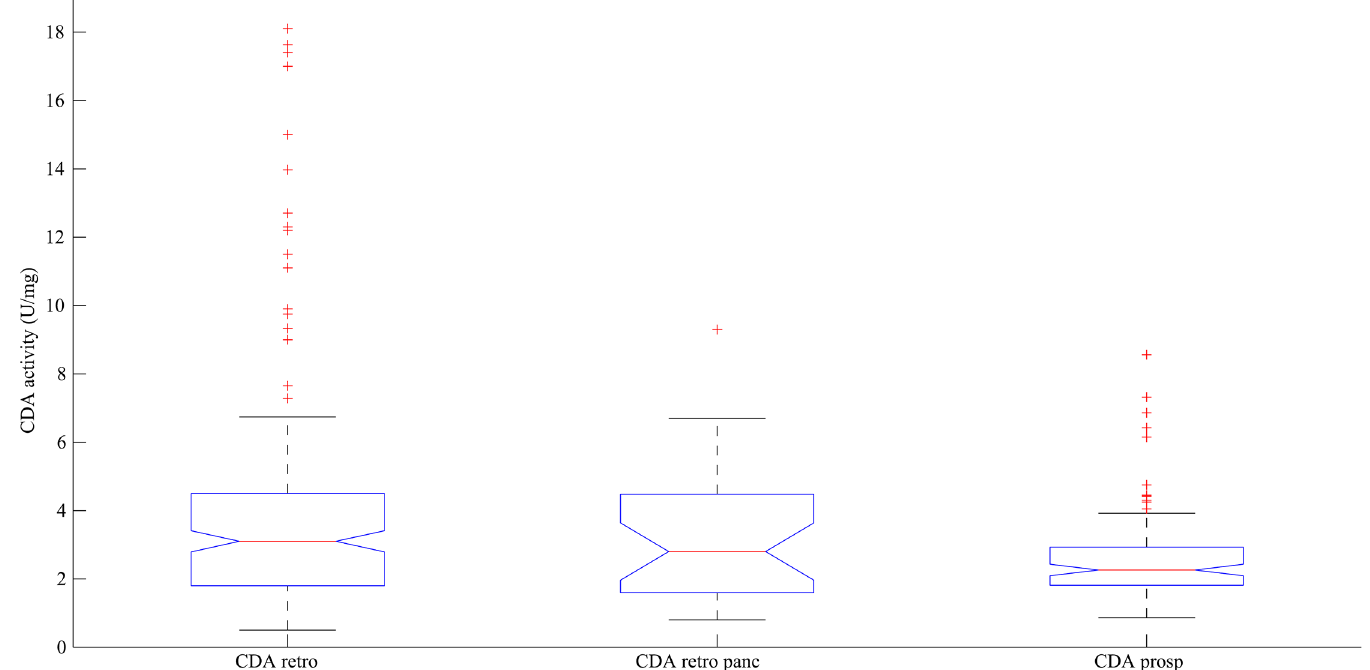
Fig 3. Boxplots of CDA activity in prospective compared to retrospective study. CDAretro stands for CDA activity in gemcitabine-treated patients for various types of cancers in the retrospective study. The boxplot in the middle represents CDA activity in the subgroup of gemcitabine-monotherapy patients in the retrospective study. CDA activities of patients from the prospective study are represented in the boxplot on the right. Isolating gemcitabine- monotherapy treated patients leads to a smoothing effect in CDA activity variability.